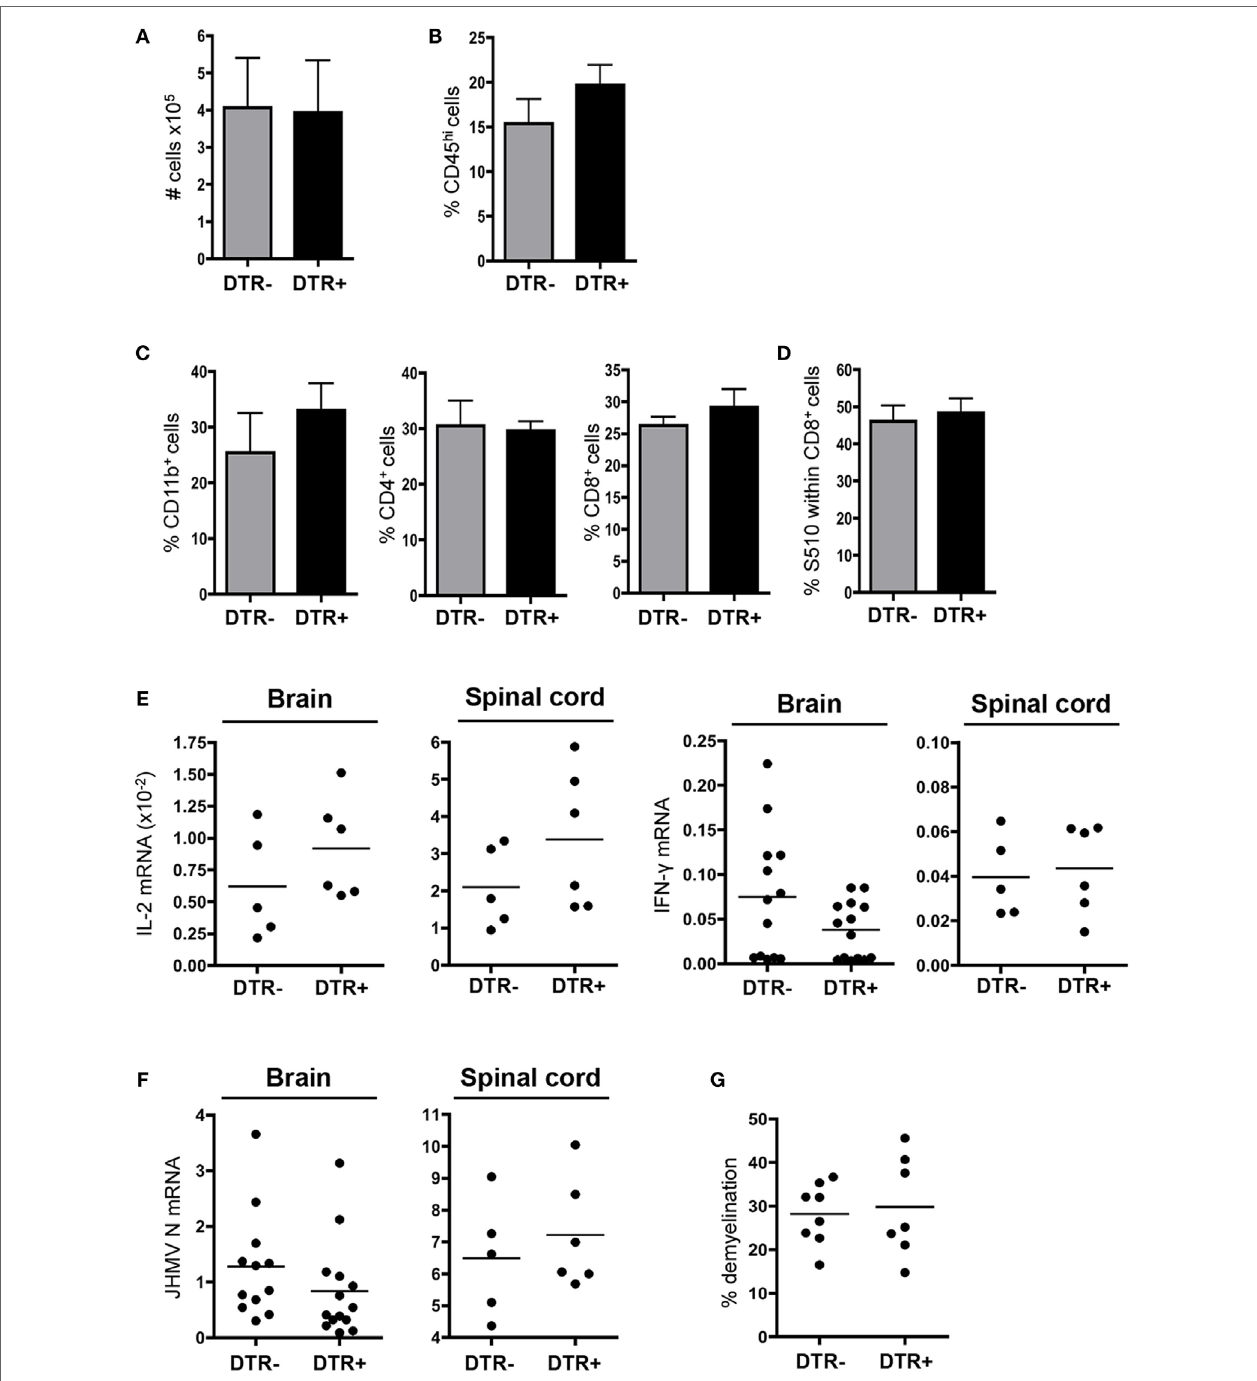
FigUre 4 | Foxp3 + Tregs do not affect cns inflammatory response during chronic JhMV infection . (a) Total cell number and (B) frequency of CNS infiltrated leukocytes (CD45 hi ) from DT-treated DTR − and DTR + mice at d28 p.i. (c) Percentages of CD11b + , CD4 + , and CD8 + T cells within CD45 hi cells and (D) frequencies of virus-specific CD8 + T cells analyzed at day 28 p.i. by flow cytometry using H-2D b /S510 MHC class I tetramers in DT-treated DTR − and DTR + mice. Data represent the mean ± SEM of at least three individual experiments with n = 4 per group per experiment. Levels of mRNA encoding IFN- γ , IL-2 (e) , as well as JHMV N (F) in brain and spinal cord of DT-treated DTR − and DTR + mice at d28 p.i. analyzed by real-time PCR and relative to GAPDH mRNA expression. Dots represent individual mice with n = 5–14, and horizontal bars indicate mean number. (g) Percentage of demyelination within white matter area analyzed in the spinal cord of DT-treated DTR − and DTR + mice at d28 p.i. Dots represent individual mouse with n = 7–8 mice per group, and horizontal bar indicates mean